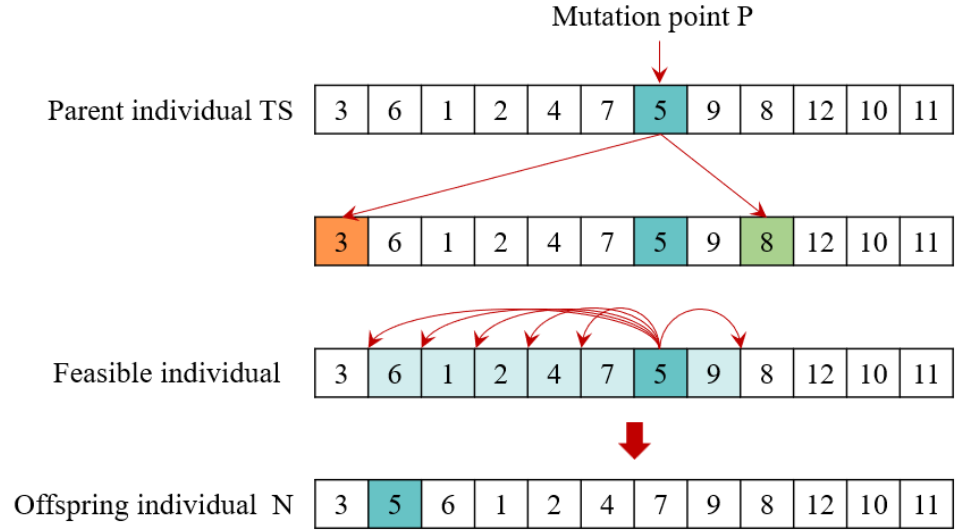
Figure 4. Individual mutation operation.